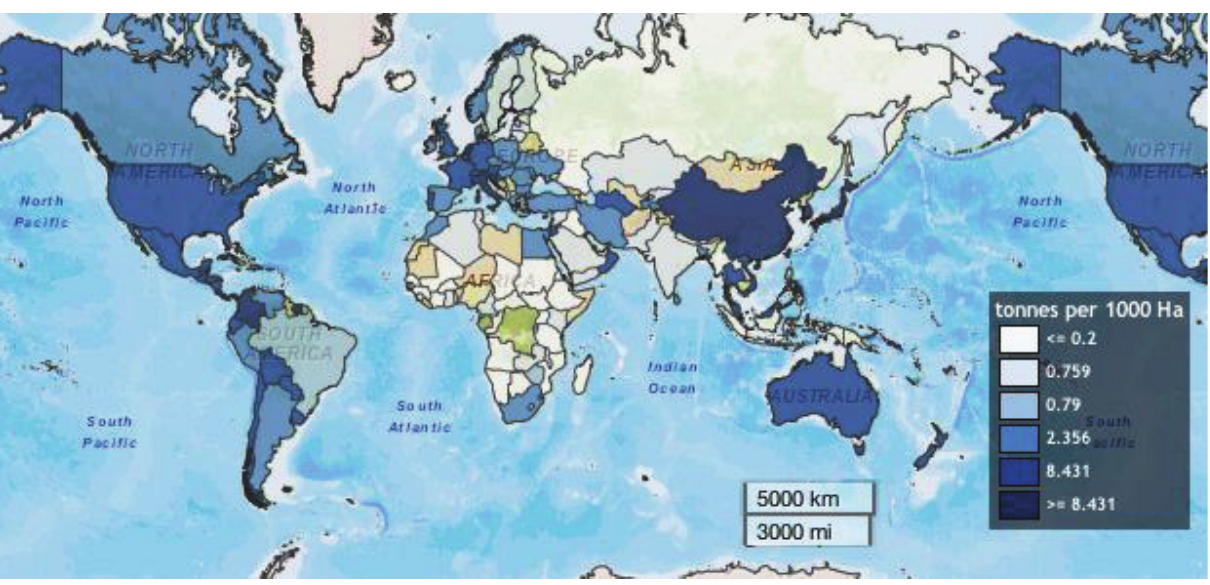
Figure 6. Average pesticide use from 1992 – 2010 on arable land and permanent crops Food and Agriculture Organization of the United Nations